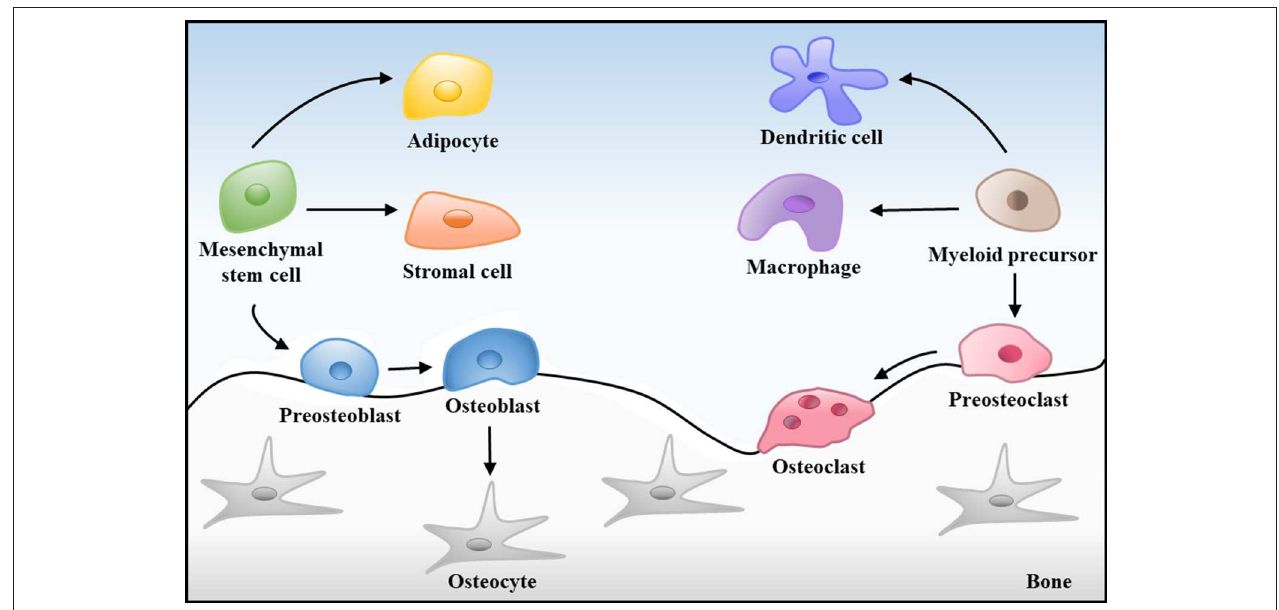
FIGURE 1 | Differentiation of bone cells